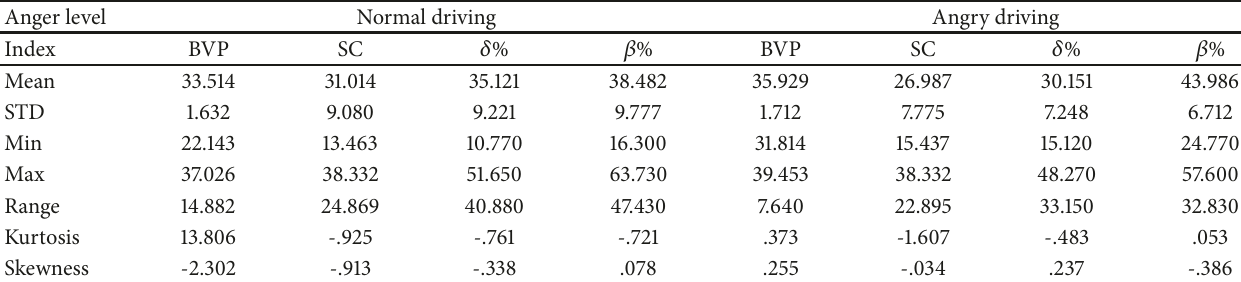
Table 3: The descriptive statistics of the biosignals and brain signals.